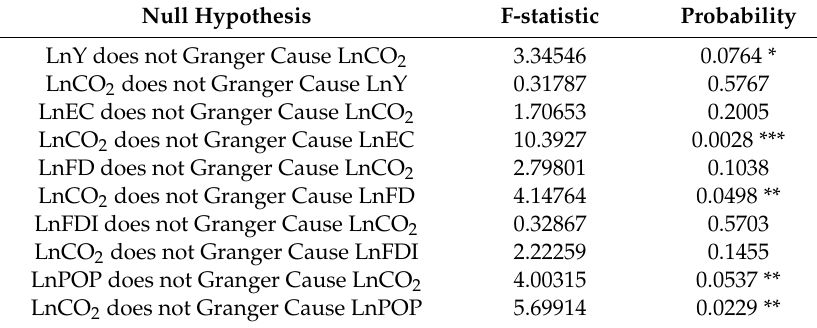
Table 11. Granger causality between CO 2 and its determinants. Null Hypothesis F-statistic